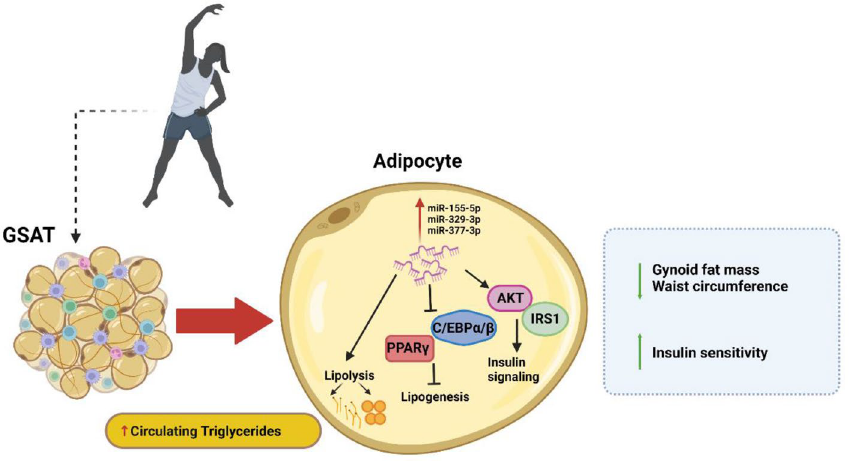
Figure 4. Proposed model of study findings showing how the exercise intervention can lead to reduced waist circumference and gynoid fat mass and improve whole-body insulin sensitivity. Exercise induces the expression of miR-155-5p, miR-329-3p and miR-377-3p in GSAT, stimulating lipolysis and increasing circulating triglycerides. Inhibition of C/EBPα/β and PPARγ leads to decreased lipogenesis, with concomitant stimulation of AKT and IRS1, and insulin signaling. Abbreviations: AKT, Protein kinase B; C/EBPα/β, CCAAT/enhancer- binding protein alpha/beta; GSAT, Gluteal subcutaneous adipose tissue; IRS1, Insulin receptor substrate 1. Diagram created in Bio-Render (https:// biore nder.